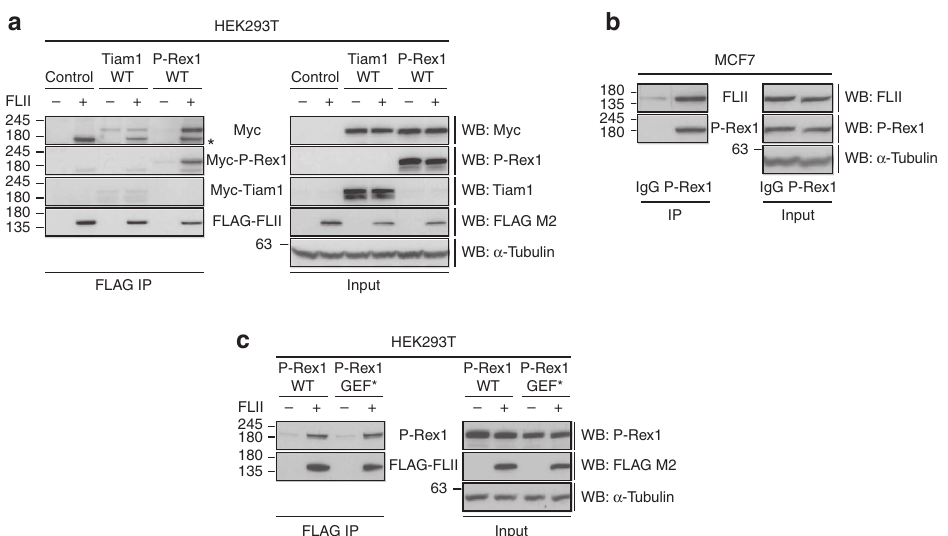
Figure 4 | FLII is a novel P-Rex1 interactor that does not bind to Tiam1. ( a ) FLAG immunoprecipitation (IP) from HEK293Tcells expressing Myc-tagged Tiam1 WTor Myc-tagged P-Rex1 WTalone or together with FLAG-tagged FLII. Co-precipitated Myc-tagged GEFs were detected by western blot analysis. * indicates background band. ( b ) Endogenous P-Rex1 IP from MCF7 cells. Co-precipitated endogenous FLII was detected by western blot analysis. ( c ) FLAG IP from HEK293T cells expressing Myc-tagged P-Rex1 WT or GEF* alone or together with FLAG-tagged FLII. Co-precipitated Myc-tagged GEFs were detected by western blot analysis. In a – c , a -Tubulin was used as a loading control. Representative western blots from three independent